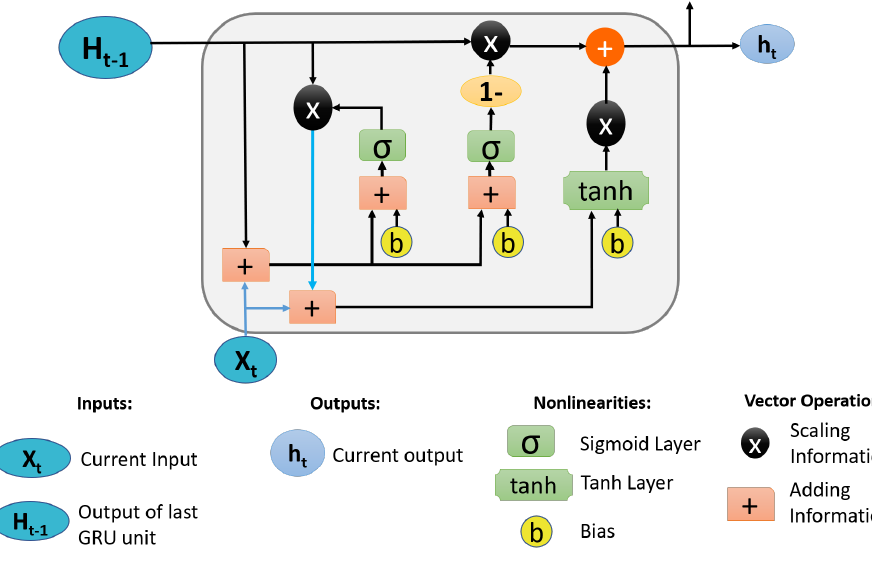
Figure 3. Gated recurrent unit (GRU)